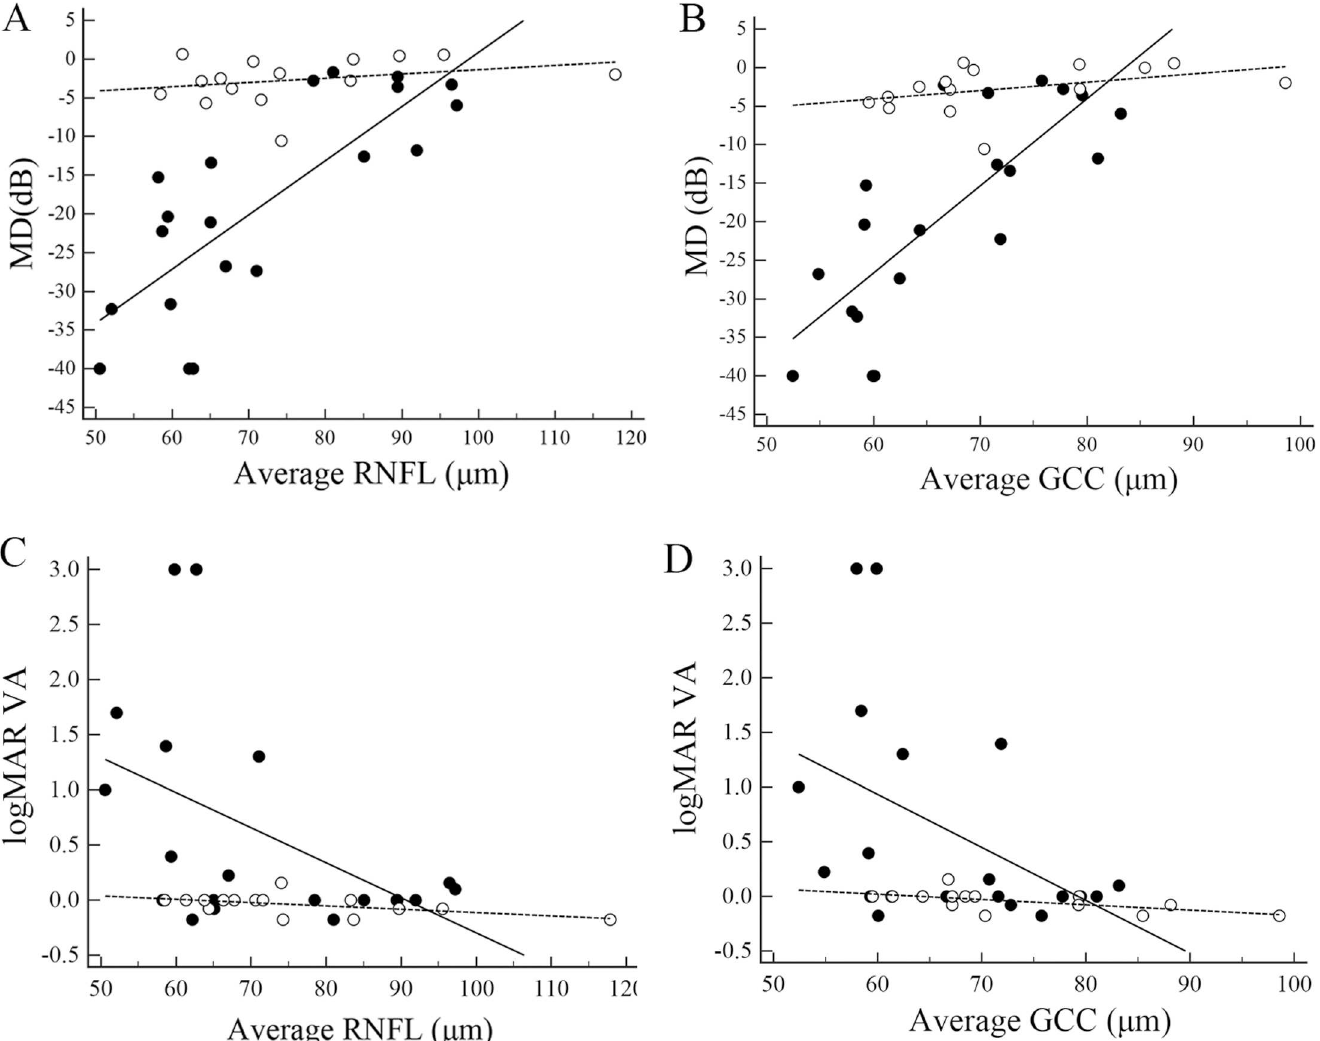
Fig 4. Structure − function relationships in all eyes. Scatter plots of mean deviation(MD) againstcircumpapillary retinal nerve fiber layer (RNFL) averagethickness (A), MD against ganglion cell complex (GCC) averagethickness (B), logMAR visual acuity (VA) againstcircumpapillary RNFL average thickness (C), and VA againstGCC averagethickness (D). Open circles and dotted lines indicate eyes with aquaporin4 antibody (AQP4 Ab)-negative optic neuritis, whereasclosed circles and solid lines indicateeyes with antibody-positiveoptic neuritis. Spearmanrank correlationcoefficients (95% confidenceinterval, P-value) for the AQP4 Ab-negative and positive-groups were 0.33 (-0.22 to 0.72, 0.23) and 0.74 (0.44 to 0.89, 0.0002), respectively, betweenMD and averageRNFL thickness (A), 0.49 (-0.03 to 0.80, 0.06) and 0.73 (0.43 to 0.89, 0.0002), respectively, betweenMD and averageGCC thickness (B), -0.57 (-0.84 to -0.07, 0.03) and -0.40 (-0.71 to 0.06, 0.08), respectively,betweenlogMAR VA and averageRNFL thickness (C), and -0.69 (-0.89 to -0.27, 0.005) and -0.52 (-0.78 to -0.10, 0.02), respectively, betweenlogMAR VA and averageGCC thickness